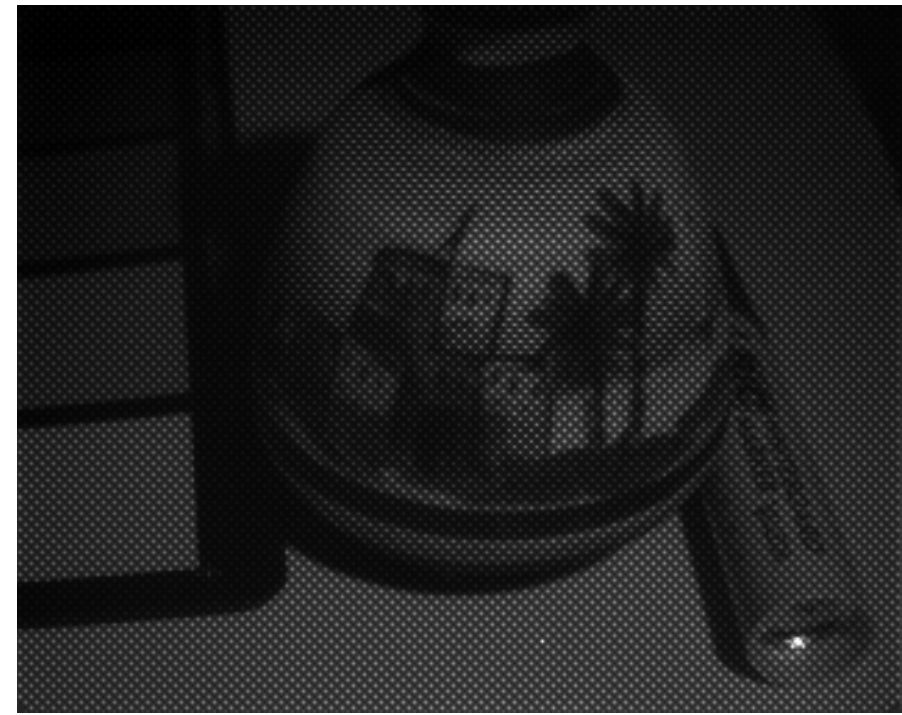
Figure 10. Raw image of scene 2 after applying the pre-processing described in Section 3.1. The integration time was of 8.049 ms. RAW image is provided as Supplementary Materials in Figure S2. Images were demosaiced with Miao et al. [46,47] binary tree algorithm for benchmark.